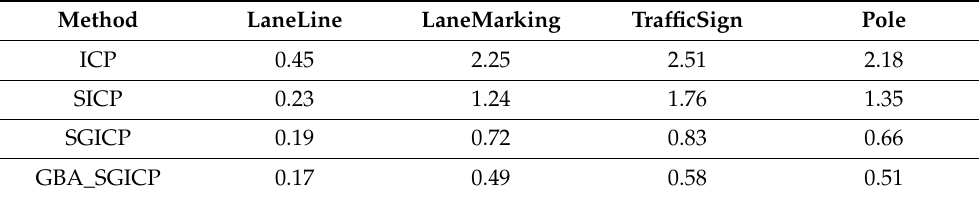
Table 1. Impact of cloud alignment algorithm on mapping accuracy (3-sigma avg.m).